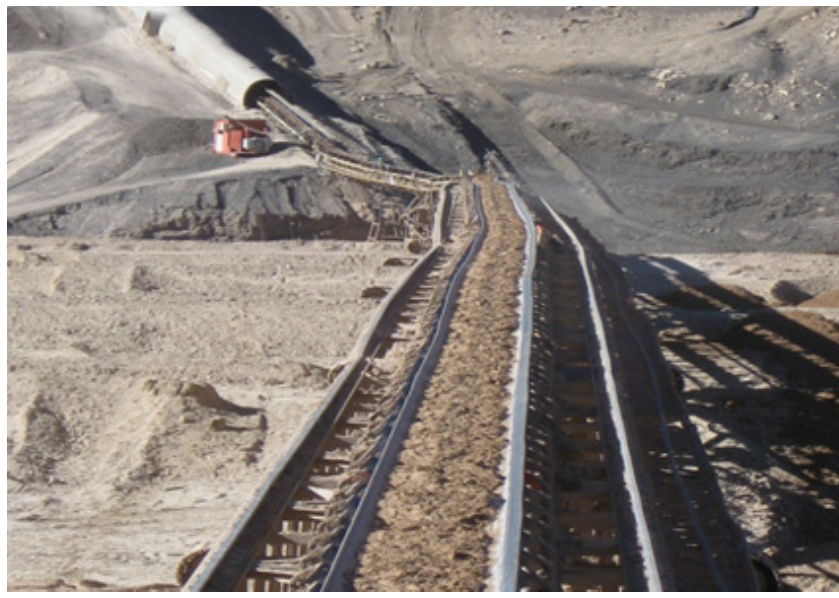
Figure 8. Typical View of Filtered Tailings Transported by a Conveyor Belt [23].